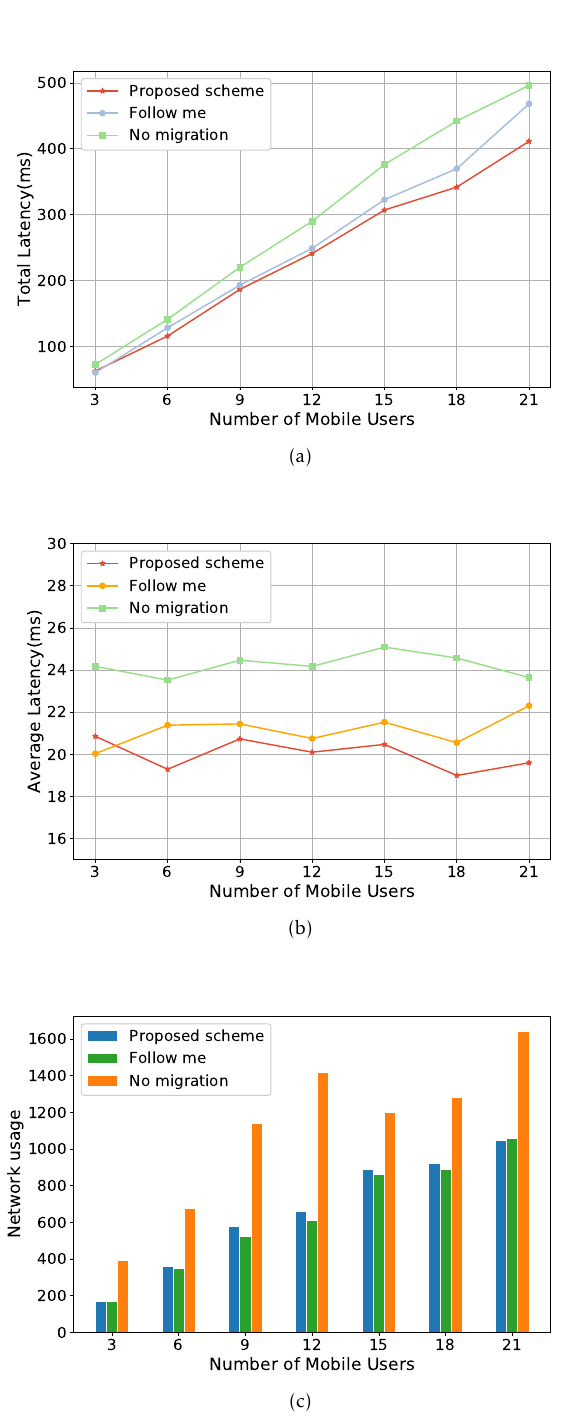
Figure 3. Comparison of three di(cid:27)erent service place- ment policies with di(cid:27)erent number of users. The average user’s sojourn time is 7s. (a) Total service latency perceived by users. (b)Average service latency perceived by users. (c) Network